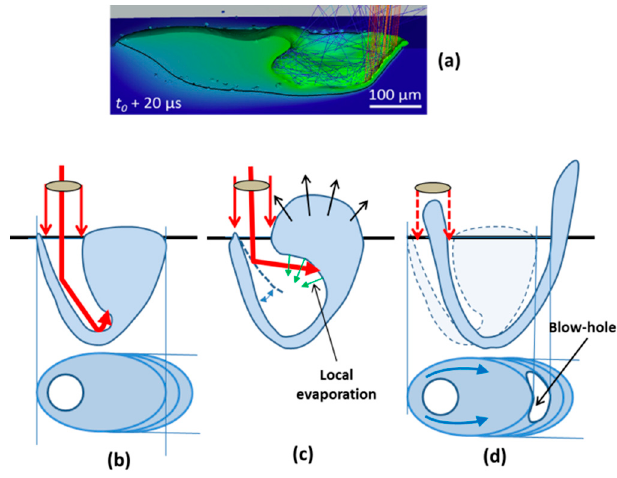
Figure 11. ( a ) Example of multi-physics simulations of the multi-reflections mechanism inside the KH [33]. Sequence of events leading to melt pool perturbation: ( b ) A low aspect ratio KH is first generated. ( c ) Due to fluctuations that modify the KH front inclination, the incident laser beam is redirected toward the melt pool whose surface is lifted and then tears; a transient cavity forms and then fills ( d ) A new melt pool is reconstructed but with a blow-hole left behind.